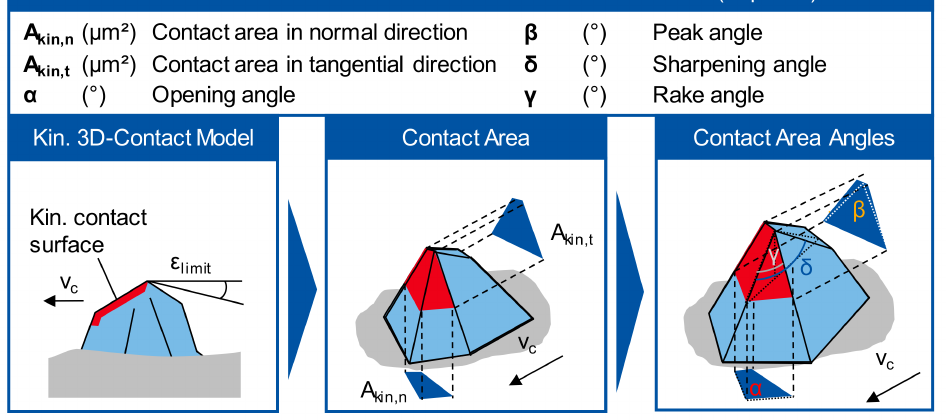
Figure 1. Parameters for the description of the properties of functional surfaces and grinding wheel